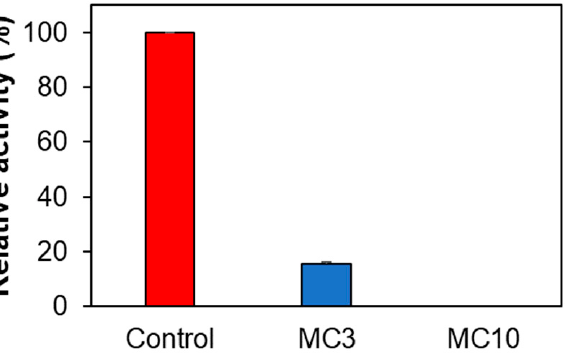
Figure 5. Effect of MC on AChE activity in SH-SY5Y cells. Results are expressed as mean ± SEM from triplicate experiments. MC3, 3 μ M; MC10, 10 μ M of MC.